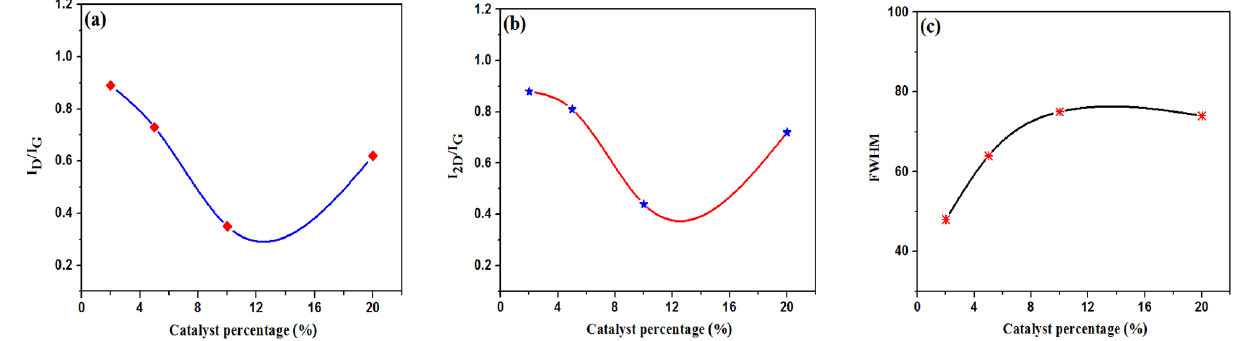
Figure 2. Results for: ( a ) I D /I G ; ( b ) I 2D /I G ; and ( c ) FWHM of the 2D band function for the different percentages of the Fe catalyst.